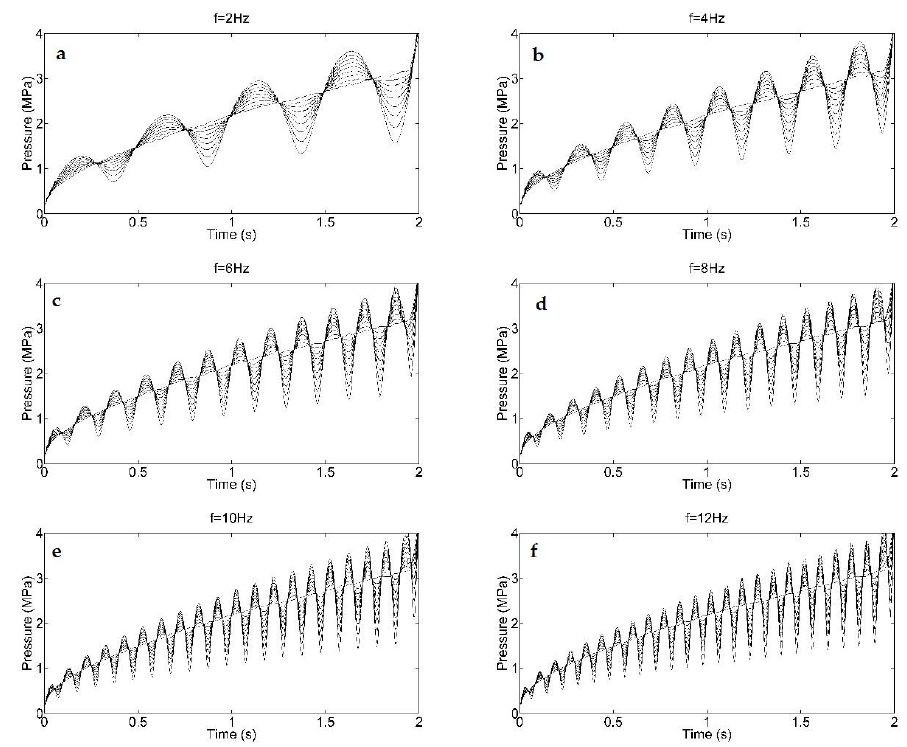
Figure 7. Injection pressure curves for different frequencies with the same ε as Figure 6. ( a ) f = 2 Hz;